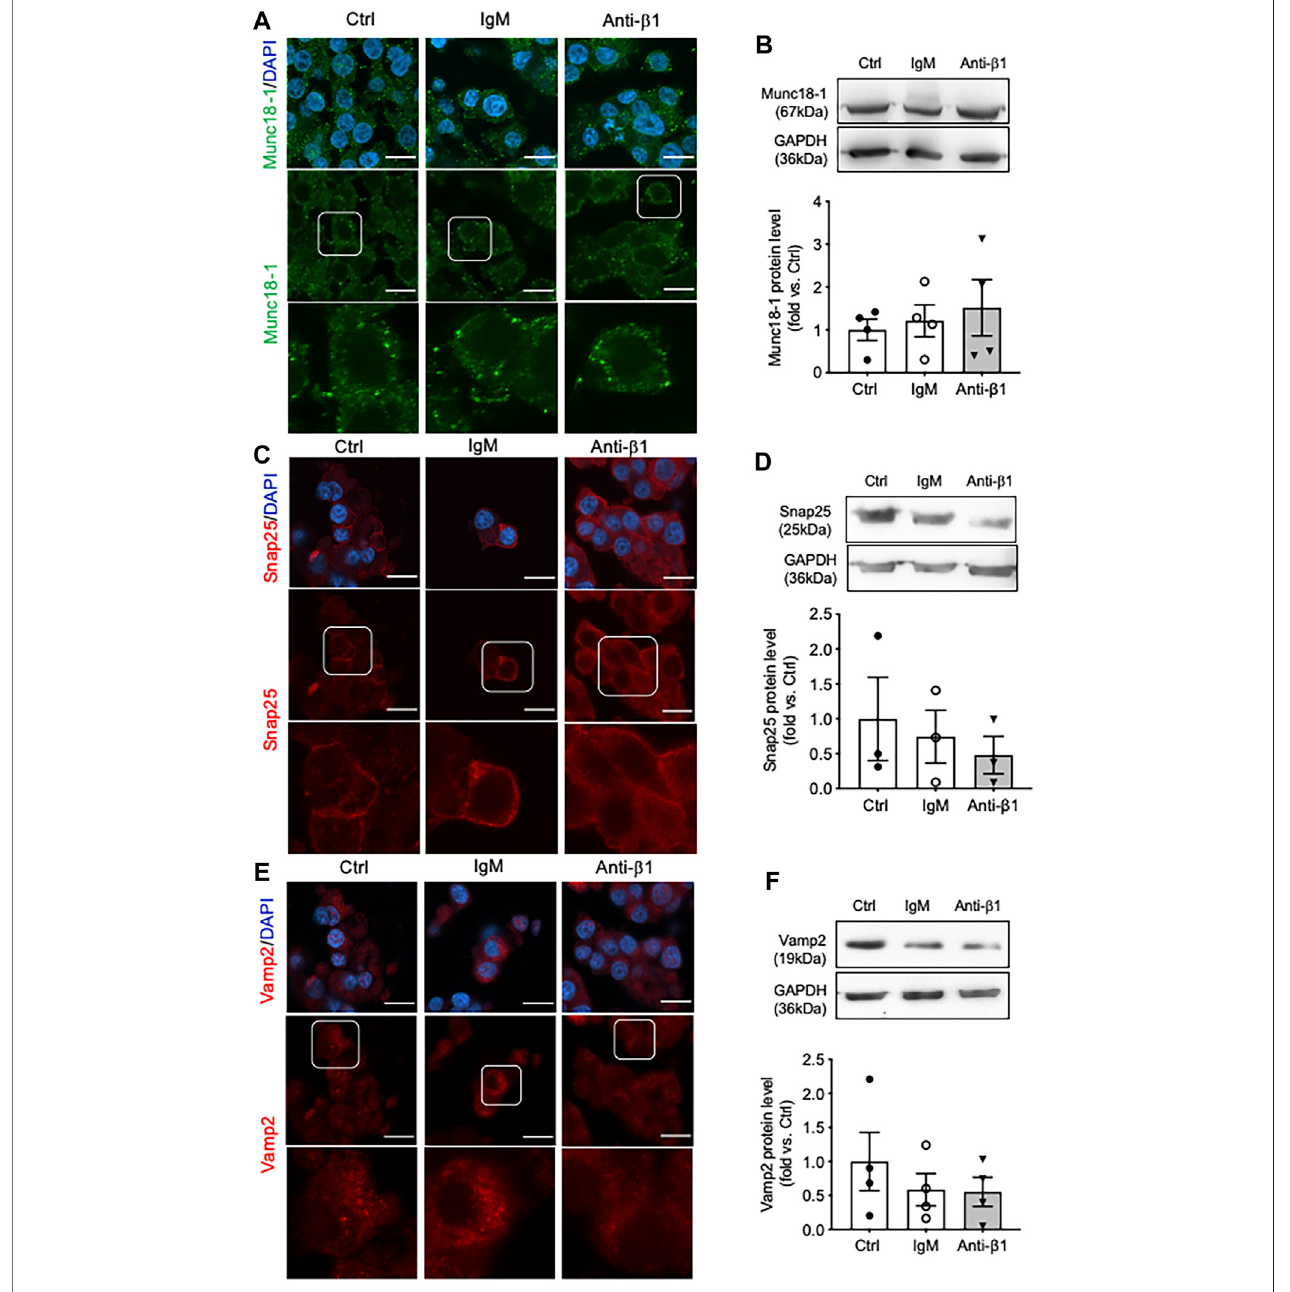
FIGURE 7 | Blocking β 1-integrin reduces Snap25, Vamp2, but not Munc18-1, protein level and immunostaining. Representative immunostaining images of (A) Munc18-1 (green), (C) Snap25 (red) and (E) Vamp2 (red) in INS-1 cells treated with anti- β 1, IgM, or untreated control (Ctrl) cultured on collagen IV for 24 h. Nuclei are counterstained with DAPI, and magni fi ed images are highlighted. Scale bar: 10 µm. Representative western blot images and data analysis for (B) Munc18-1, (D) Snap25, and (F) Vamp2 protein levels. Data are expressed as mean ± SEM ( n = 3 – 4 experiments/group).